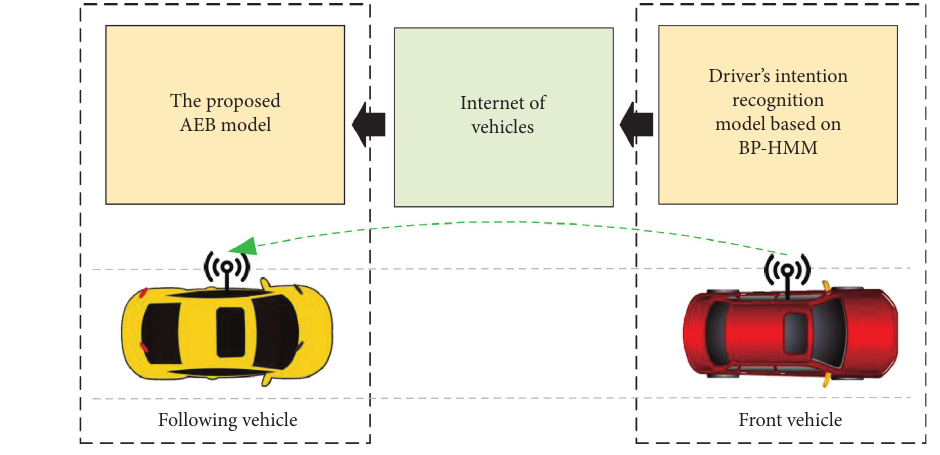
Figure 1: Schematic diagram of system work.